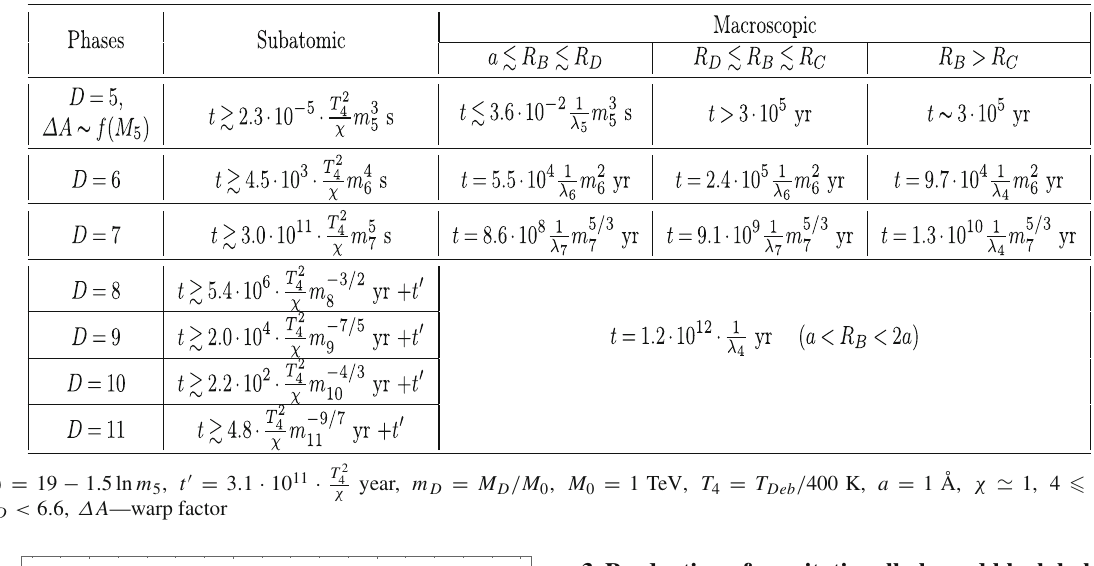
sion governed by the radius of extra dimensions R D and the crossover radius R C . The last phase corresponds to the growth from R C to the size of the black hole with the mass comparable to the mass of the Earth